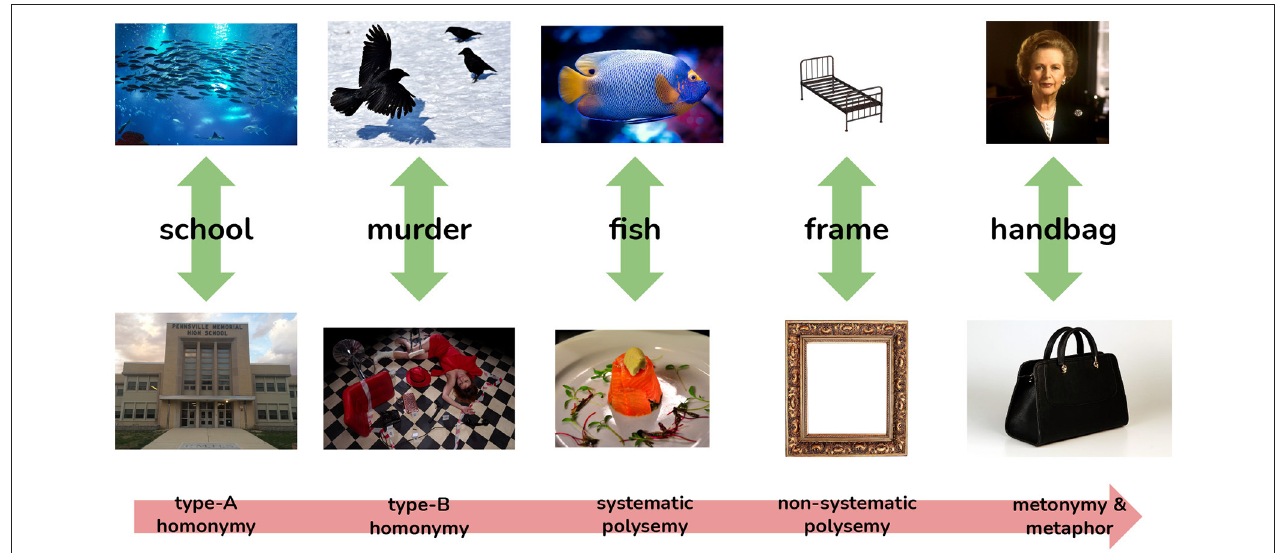
FIGURE 1 | The spectrum of polysemy, representing how certain kinds of sense distinctions correspond to the ease and agreement with which these distinctions are made by